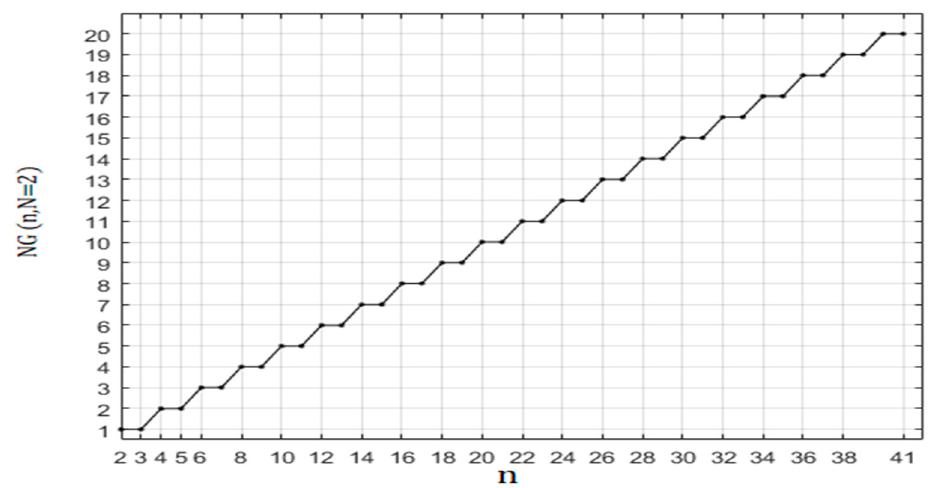
Figure 9. Dependence of the number of graphs NG (n, N = 2) as a function of n. (b) General expressions of the number of graphs (paths) when the optimal number of drones is 3 (N =